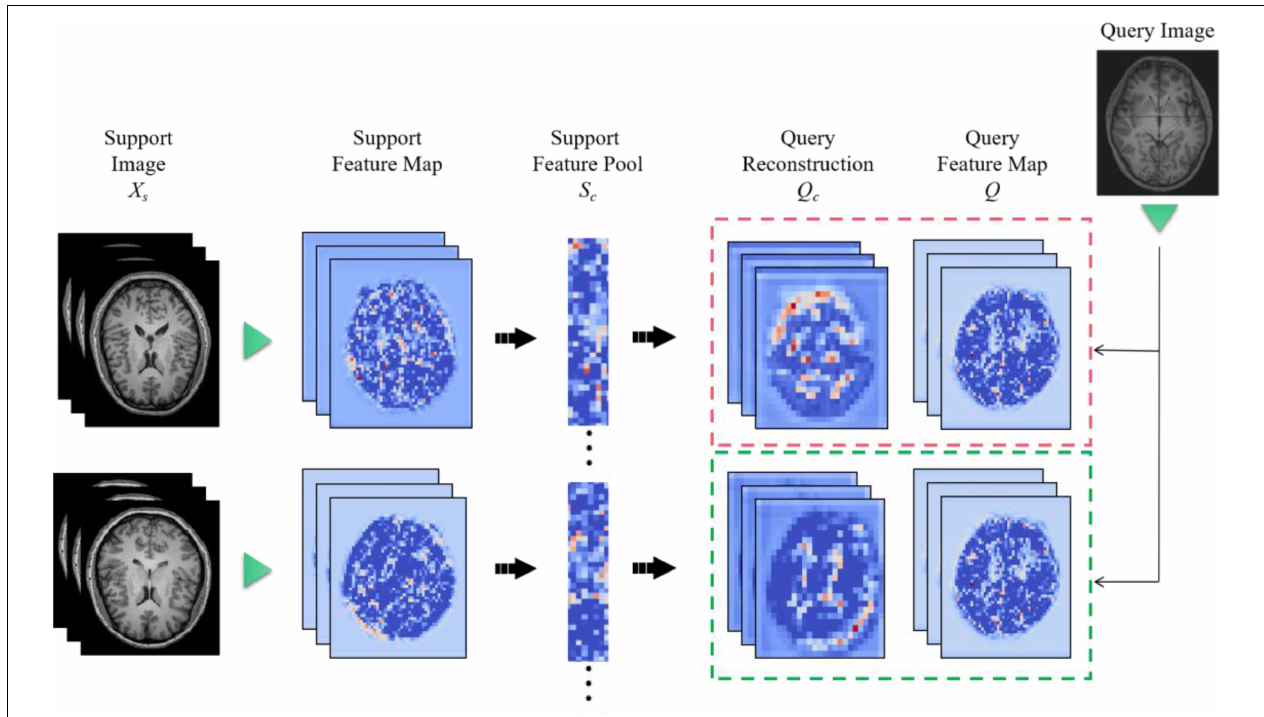
FIGURE 8 | Feature map reconstruction networks network structure